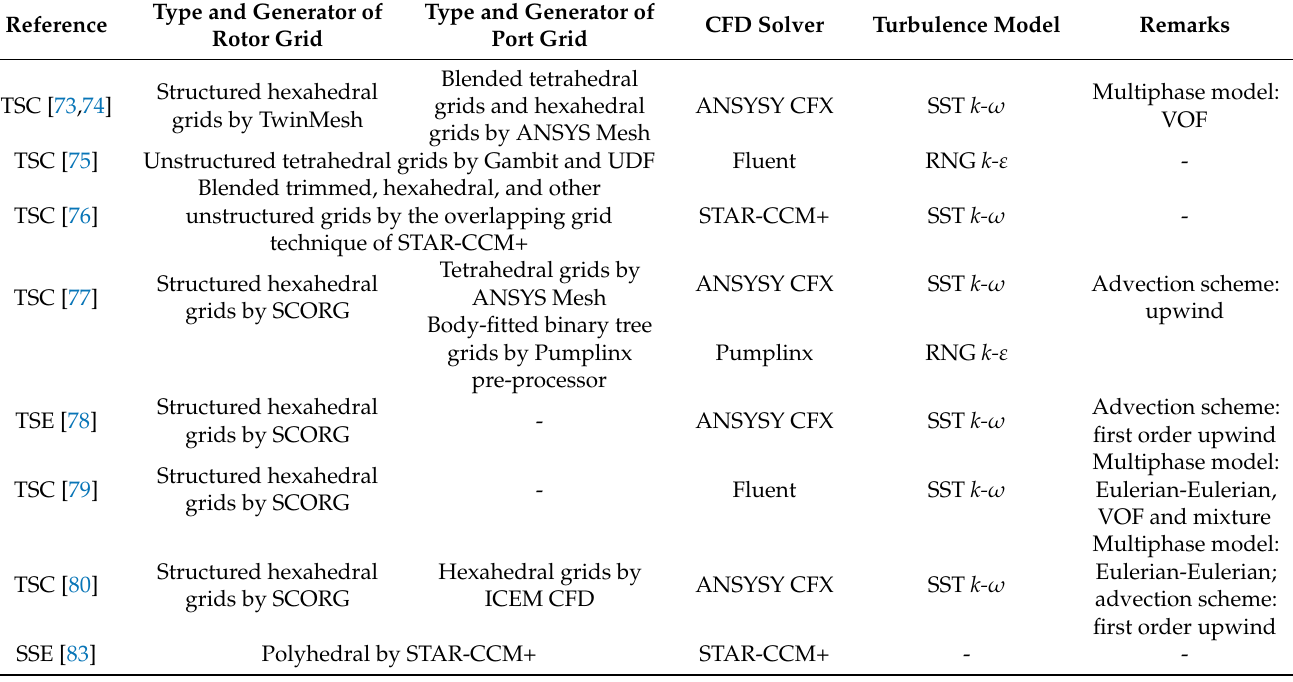
Table 1. Key information of recently reported CFD simulations of screw